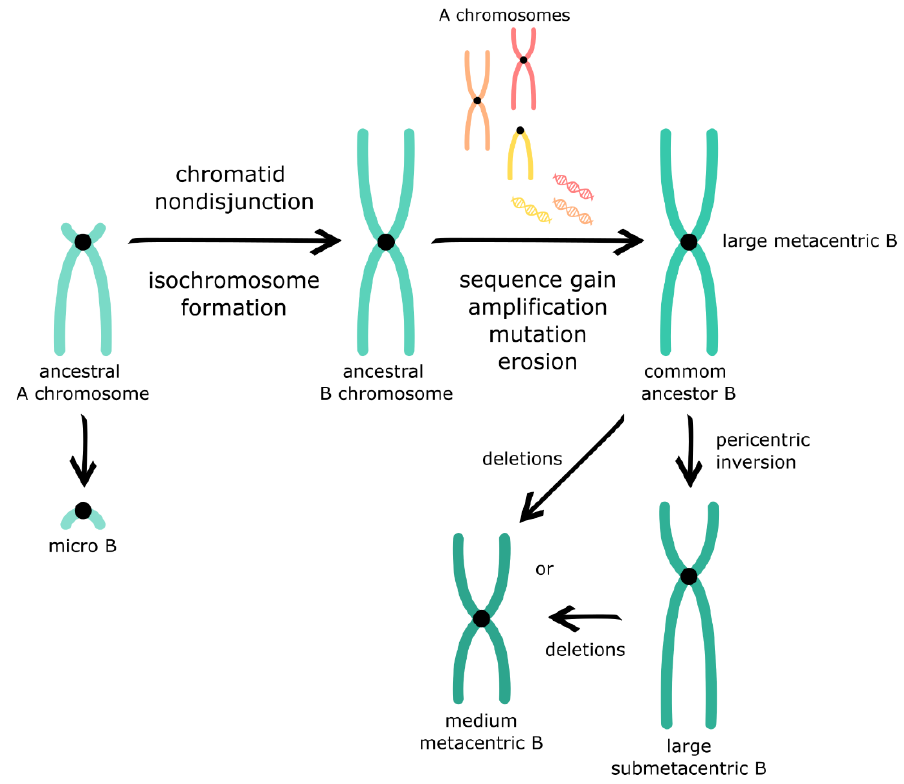
Figure 3. Psalidodon B chromosomes birth and evolution